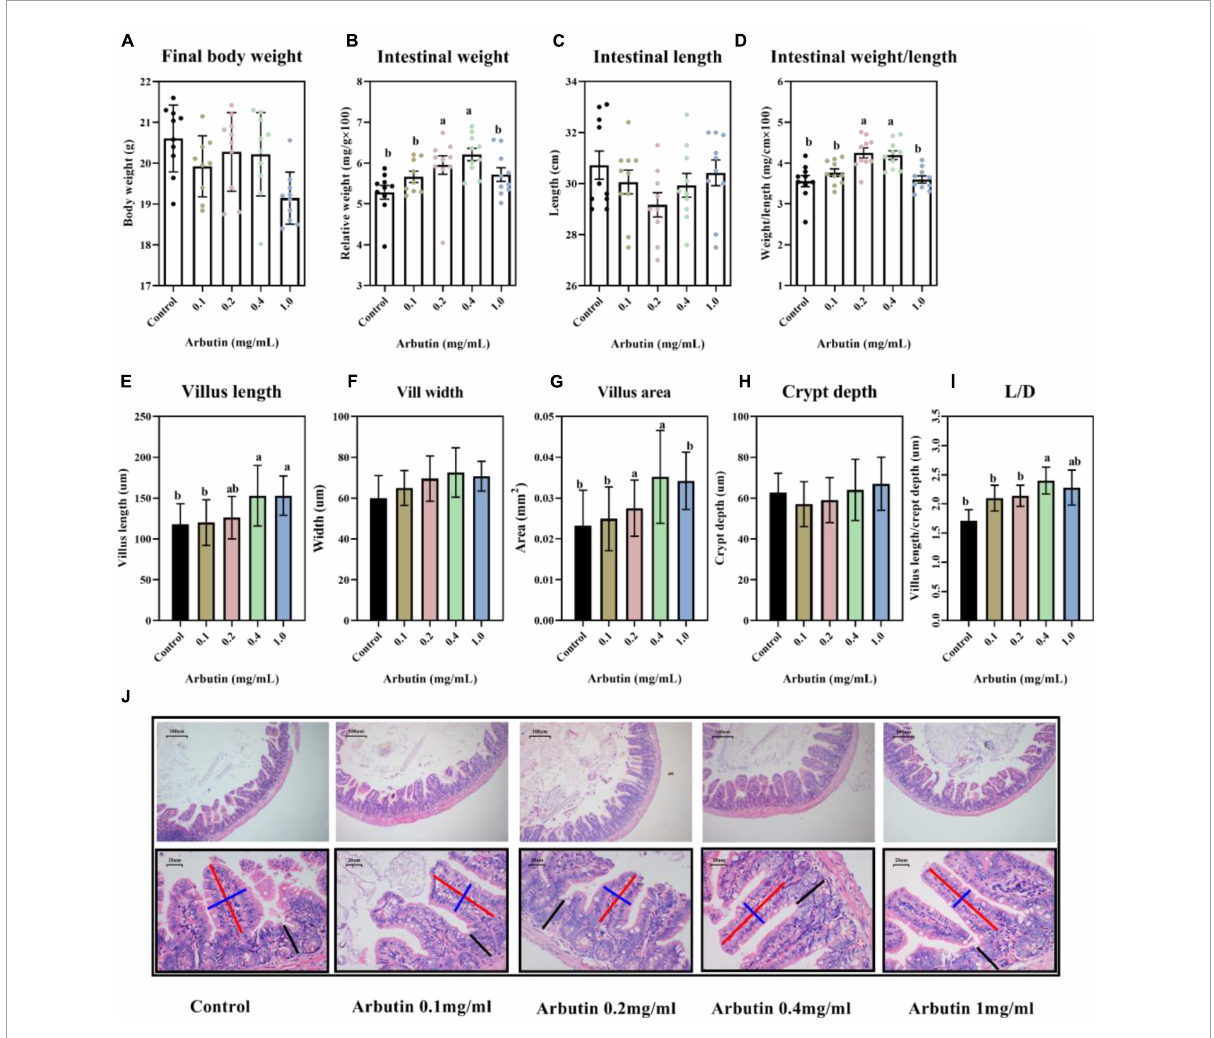
FIGURE1 Oral arbutin improves gut development. Final body weight (A) , relative intestinal weight (B) , intestinal length (C) , intestinal weight/length (D) , villus length (E) , villus width (F) , villus areas (G) , crypt depth (H) , L/D (I) , and HE staining of jejunum and ileum (J) . Values are presented as the means ± SEMs. Differences were assessed by one-way ANOVA and denoted as follows: a and b indicate significant differences in each group.